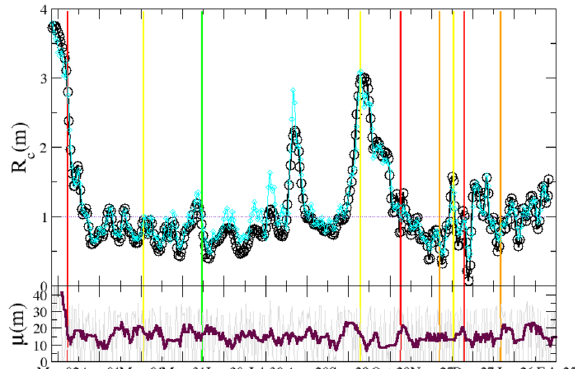
Figure 2. (Upper panel) The case reproduction number R c ( m ) of COVID-19 for the Lombardy from 02/24/2020 up to 02/18/2020. Color vertical lines indicate the starting time of different containment measures (see caption of Fig. 1). Black circles represent R c ( m ) obtained by means of the log-likelihood maximization procedure whereas cyan diamonds are used for R c ( m ) estimated from the WT method [Eq. (5) in “Methods”]. (Lower panel) The daily number of imported cases µ( m ) estimated by the log-likelihood maximization procedure is plotted in thin grey whereas solid line is used for its weekly average.